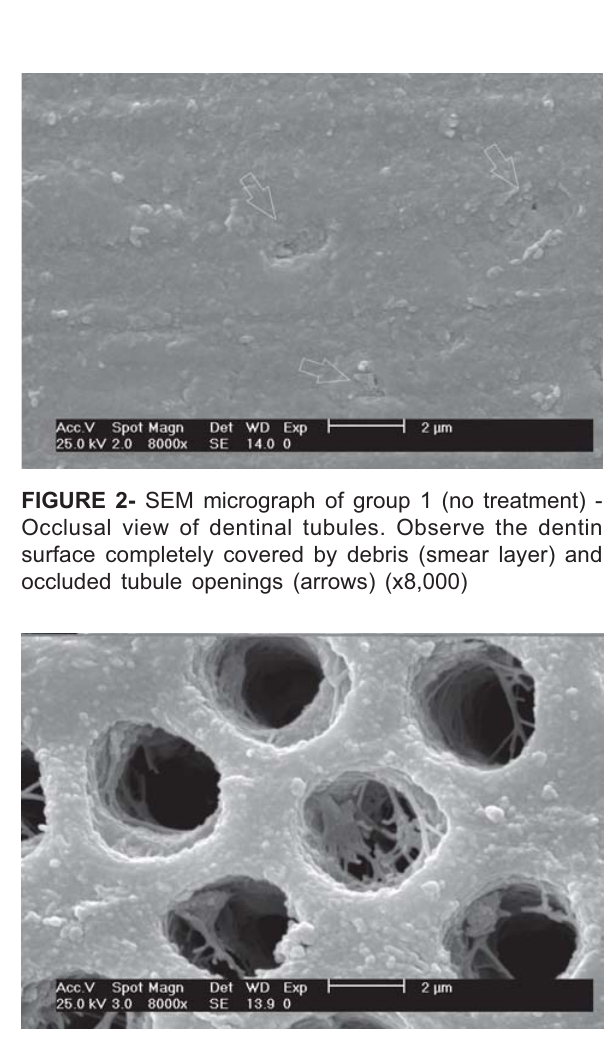
FIGURE 5- SEM micrograph of group 2 (37% phosphoric acid etching) - Lateral view of dentin surface. Observe the tubule openning free of debris (arrow) and with a funneled aspect.